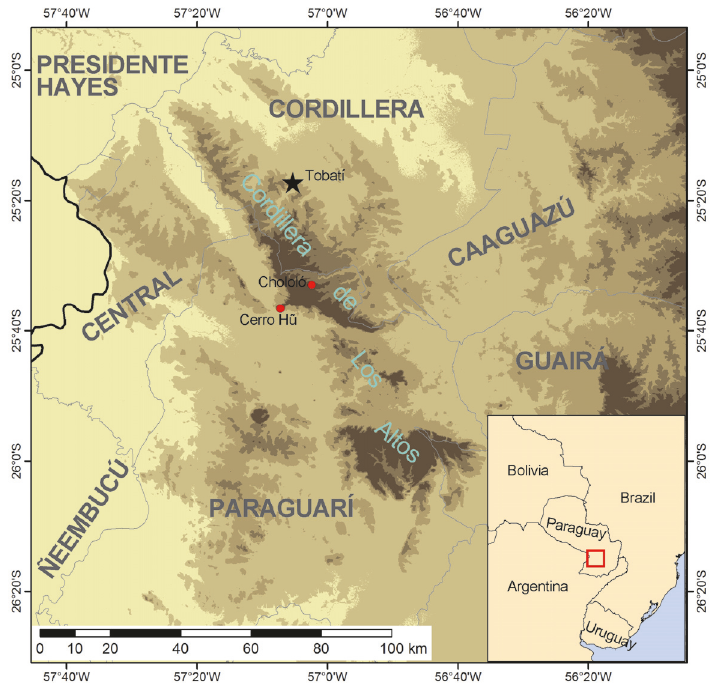
Figure 6: Known records of Phyllopezus heuteri showing the type locality (black star) and additional localities (red dots). Capitalized names refer to Paraguayan Departments.